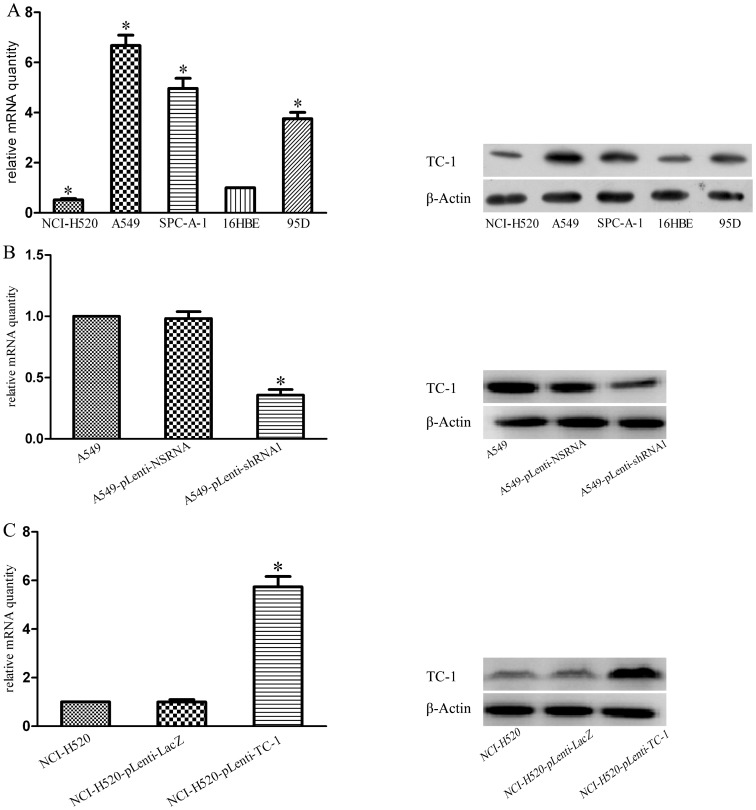
Stable clones of NSCLC cells overexpressing or downregulating TC-1 were constructed successfully.qRT-PCR and western blotting showed that A549, SPC-A-1, and 95D cells express high levels of TC-1 mRNA and protein and that NCI-H520 cells express low levels of TC-1 mRNA and protein (A). The qRT-PCR and western blotting results shown in B and C, respectively, show that TC-1 mRNA and protein are significantly downregulated in A549-pLenti-shRNA1 cells and significantly upregulated in NCI-H520-pLenti-TC-1 cells compared with the controls. The columns represent the average of the relative mRNA quantity from at least three independent experiments. The bars show the SE. *indicates statistically significant changes (P<0.05) among five groups (A) or three groups (B, C).